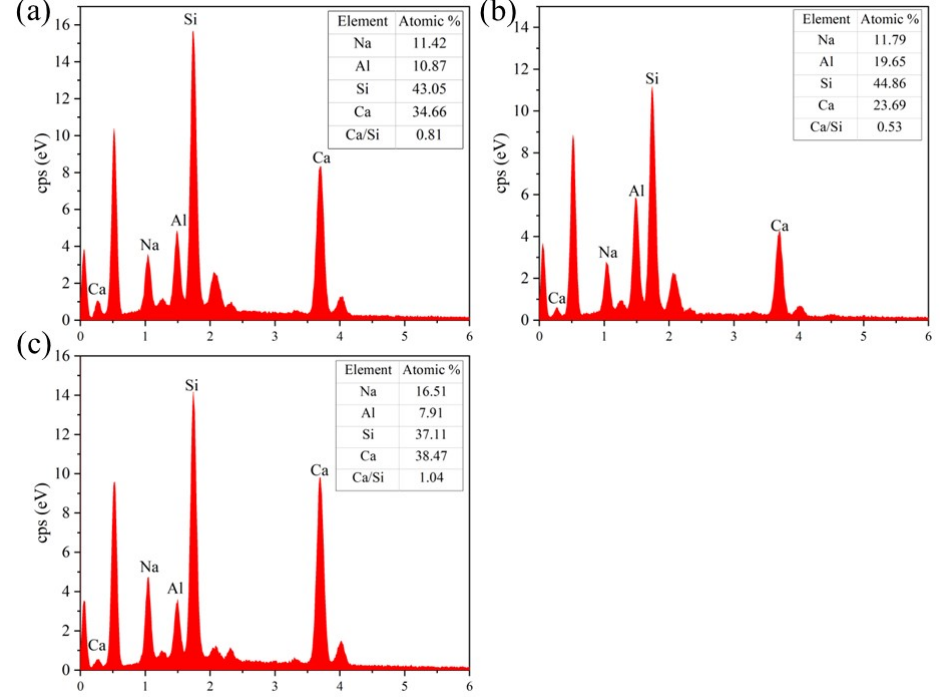
Figure 24. EDS diagram of bonding interface (24 h): ( a ) Mix MK; ( b ) Mix RSM; ( c ) Mix GGBS.